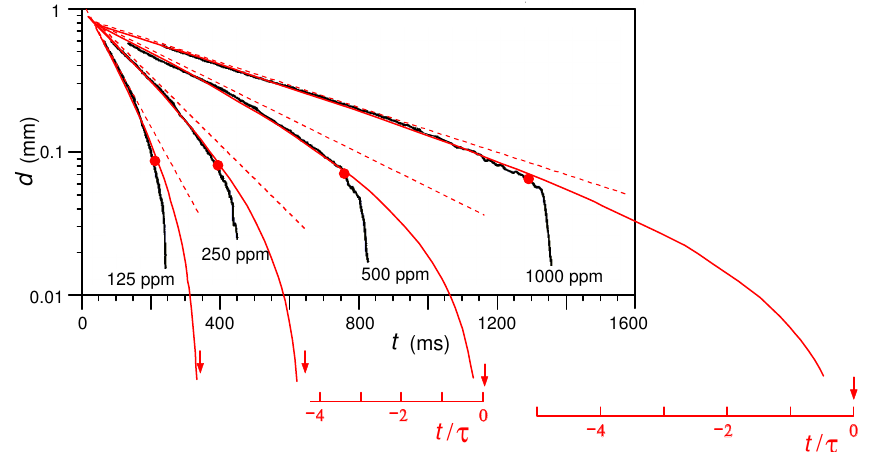
Figure 9. The time dependence of the thread thickness d = 2 a 0 . Red solid curves: theoretical results (cf. Section 3.3). Thick black curves: experimental data for semidilute aqueous solutions of Praestol-2540 with different concentrations from 125 to 1000 ppm (cf. Figure 5 of ref. [18]). Red circles indicate the onset of significant deviations between theoretical and experimental curves. The theoretical breakup points are indicated with red arrows for each red curve. For the two highest concentrations, we also indicate the reduced time t / τ (with t = 0 corresponding to the theoretical breakup). Thin red dashed lines indicate the exponential asymptotic behavior at short times (according to Equation